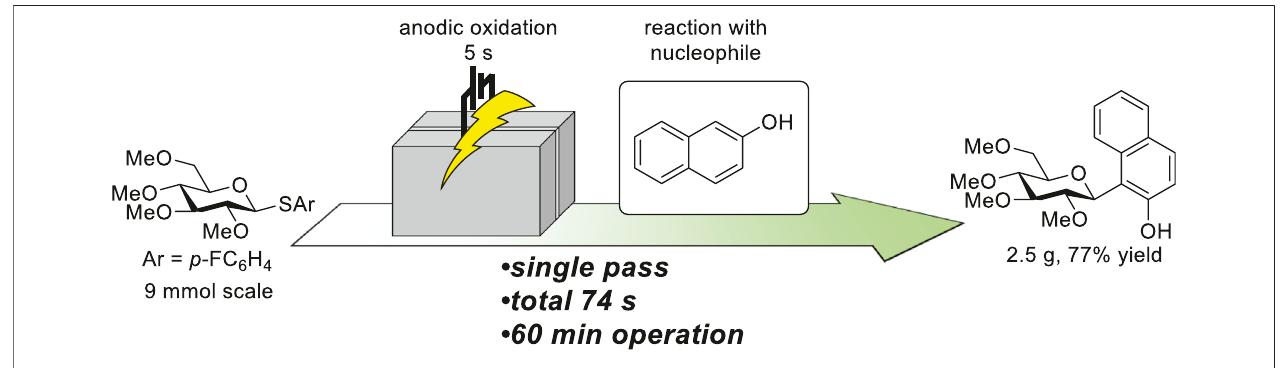
FIGURE 4 | Flash and continuous production of C -arylglycoside. See Supplementary Information for detailed